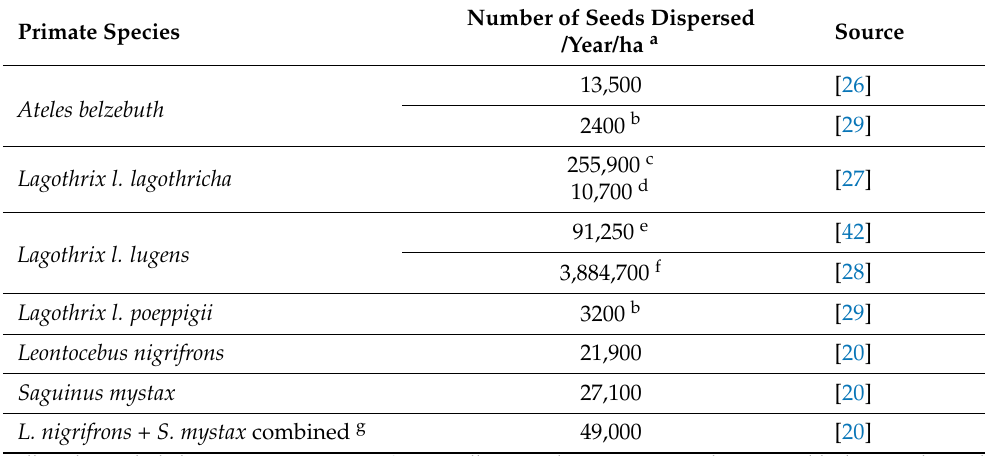
Table 6. Seed rain expressed as the number of seeds dispersed per ha and year. All values rounded to the nearest 100.